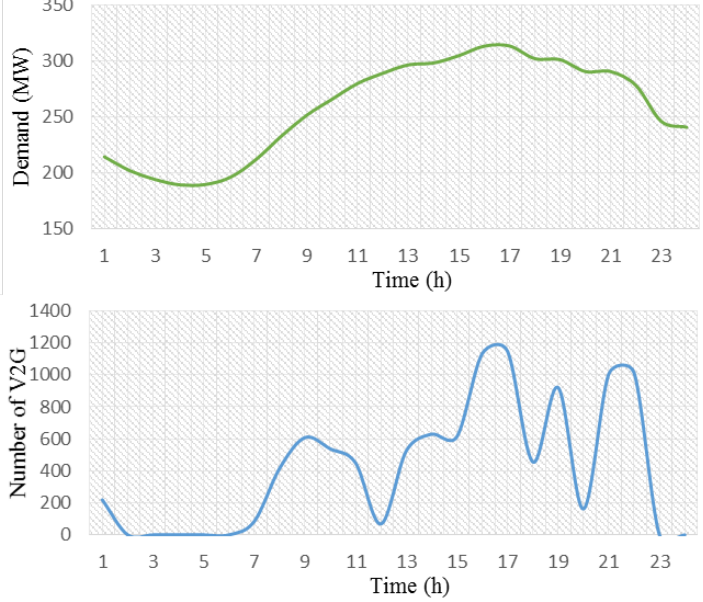
Figure 5. Load demand and number of V2G units in a day ahead scheduling.